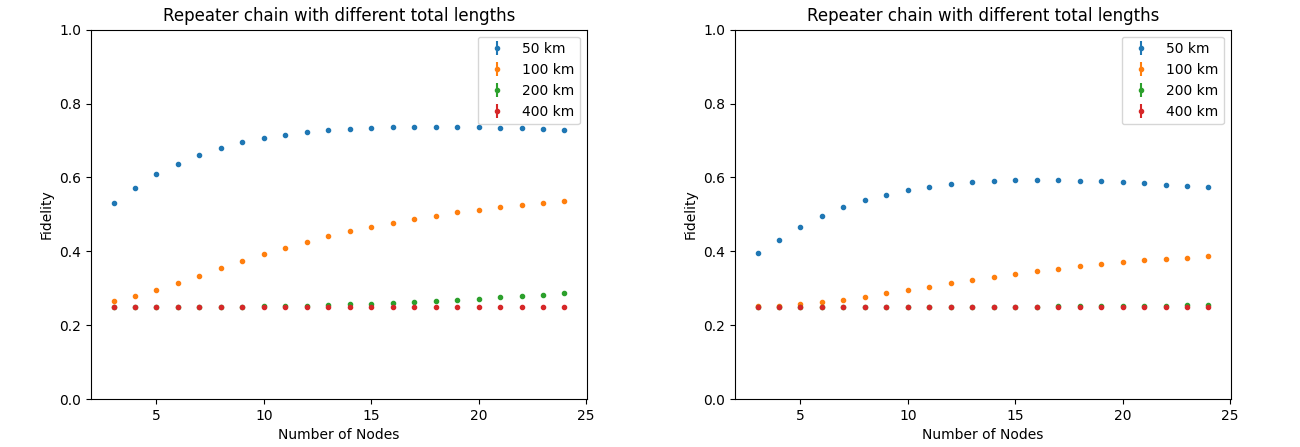
Figure 5. Fidelity vs. number of nodes, for different total lengths; ( left ) p di = 0.006, p dl = 0.015; ( right ) p di = 0.012, p dl = 0.025. In both cases, T 1 = ∞ and T 2 = 1.46 s. No purification is